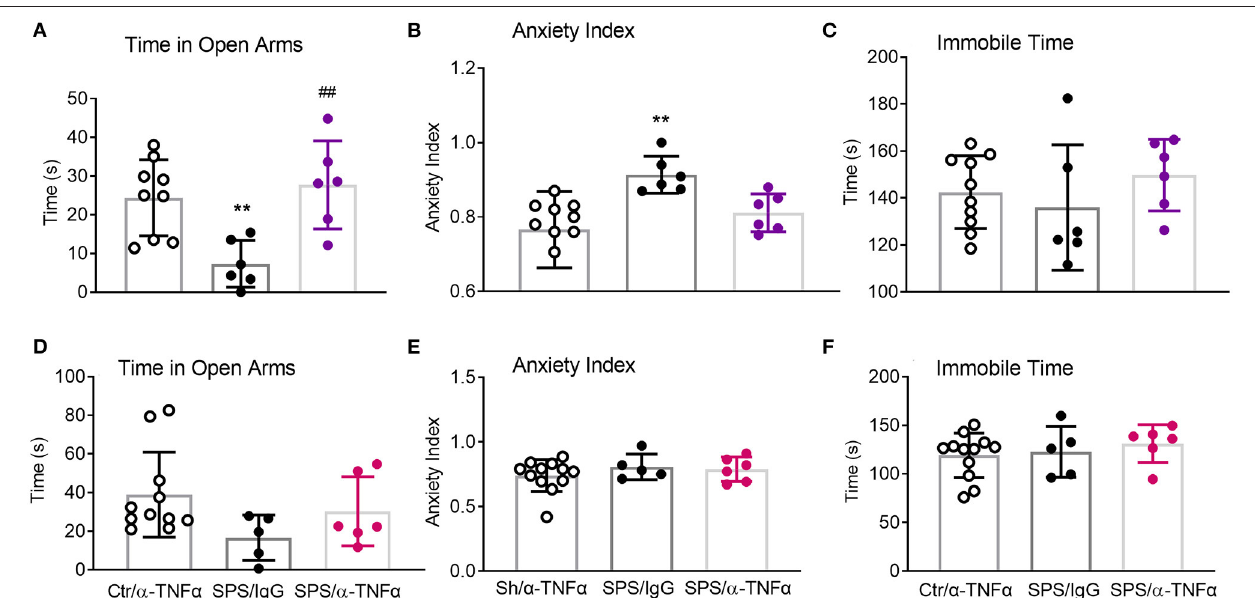
FIGURE 11 | Anti-TNF- α antibody treatment had mixed effects on EPM parameters in males. Time in Open Arms (A) , Anxiety Index (B) , and Immobile time (C) were assessed in males (A–C) and females (D–F) , respectively. Data from sham controls receiving IgG and sham controls receiving anti-TNF α antibody injections were combined, and compared to SPS + IgG and SPS + α -TNF- α . SPS produced anxiety-like behaviors in male rats (A,B) , but not in female rats (D,E) . Anti-TNF- α antibody treatment reversed decreased time in open arms ( A , ## p < 0.01), but not the increased anxiety index (B) . Data are presented as scatter plots, showing mean ±